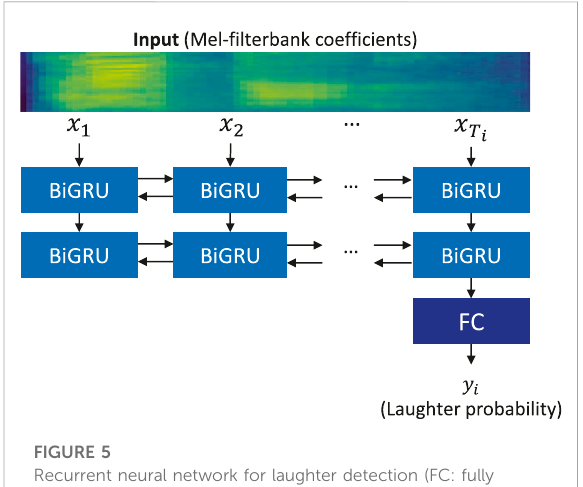
FIGURE 5 Recurrent neural network for laughter detection (FC: fully connected layer).